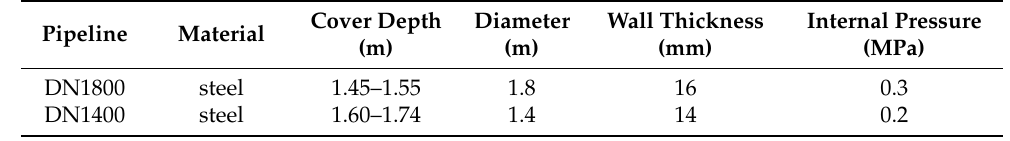
Table 1. Summary of some of the typical characteristics of the pipelines in the YRNE Project.